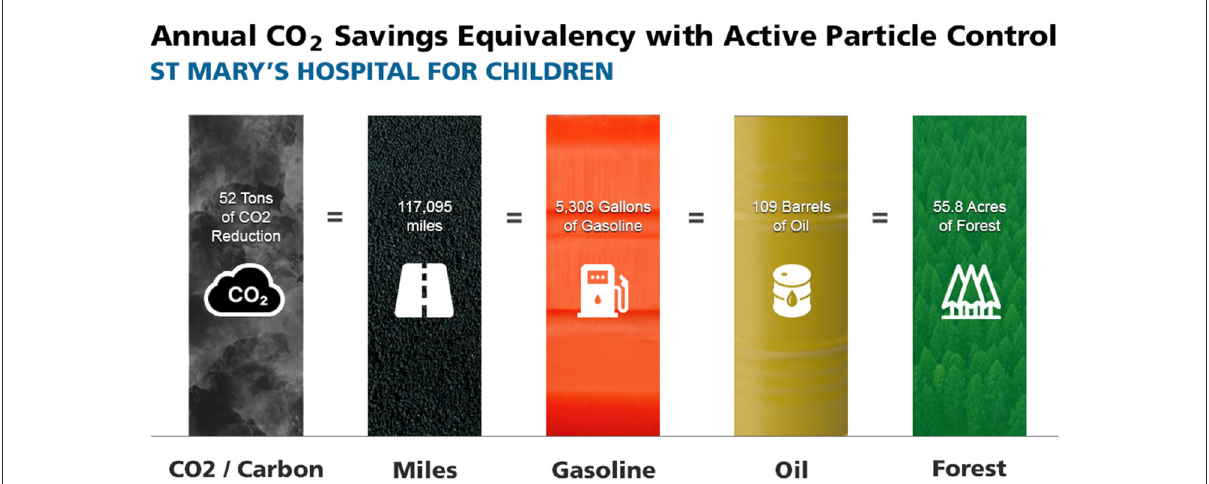
FIGURE3 Annual carbon savings from the deployment of ACTIVE Particle Control TM (APC) technology. The 51.9 ton reduction in annual carbon dioxide (CO 2 ) generation is equivalent to 117,095 miles driven with a typical passenger car, the consumption of 5,308 gallons of gasoline, the consumption of 109 barrels of crude oil, or the carbon sequestered by 55.8 acres of United States forests (8). All data collected prior to